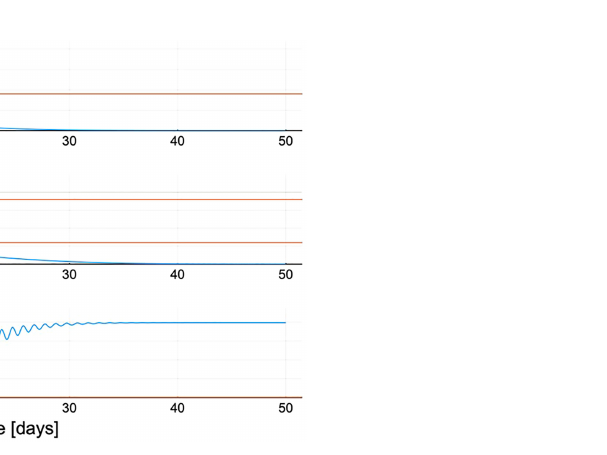
FIGURE 2 | Quanti fi ed new model hormone concentration transient responses after simulated thyroidectomy at time zero. After updating the TSH secretion function, TSH peaks approximately 1,000 mU/L. Red lines shown are the minimum for T4 (max ≈ 105) and max and min range for T3 and